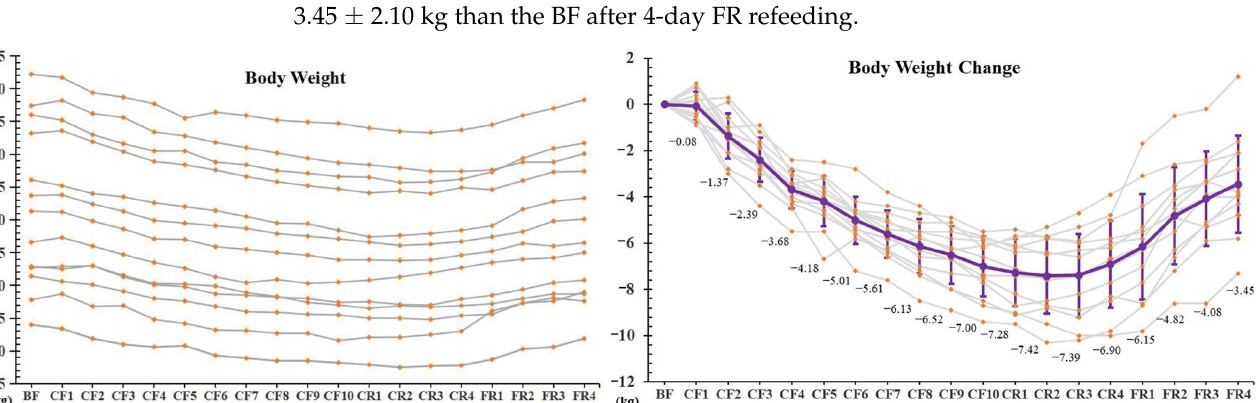
Figure 1. The alterations of body weight during 10-day CF and refeeding period. ** p < 0.01 vs. BF; # p < 0.05, ## p < 0.01, vs. CF10, n = 13. BF: before fasting, CF: complete fasting, CR: calorie restriction, FR: full recovery; the number depicts days.